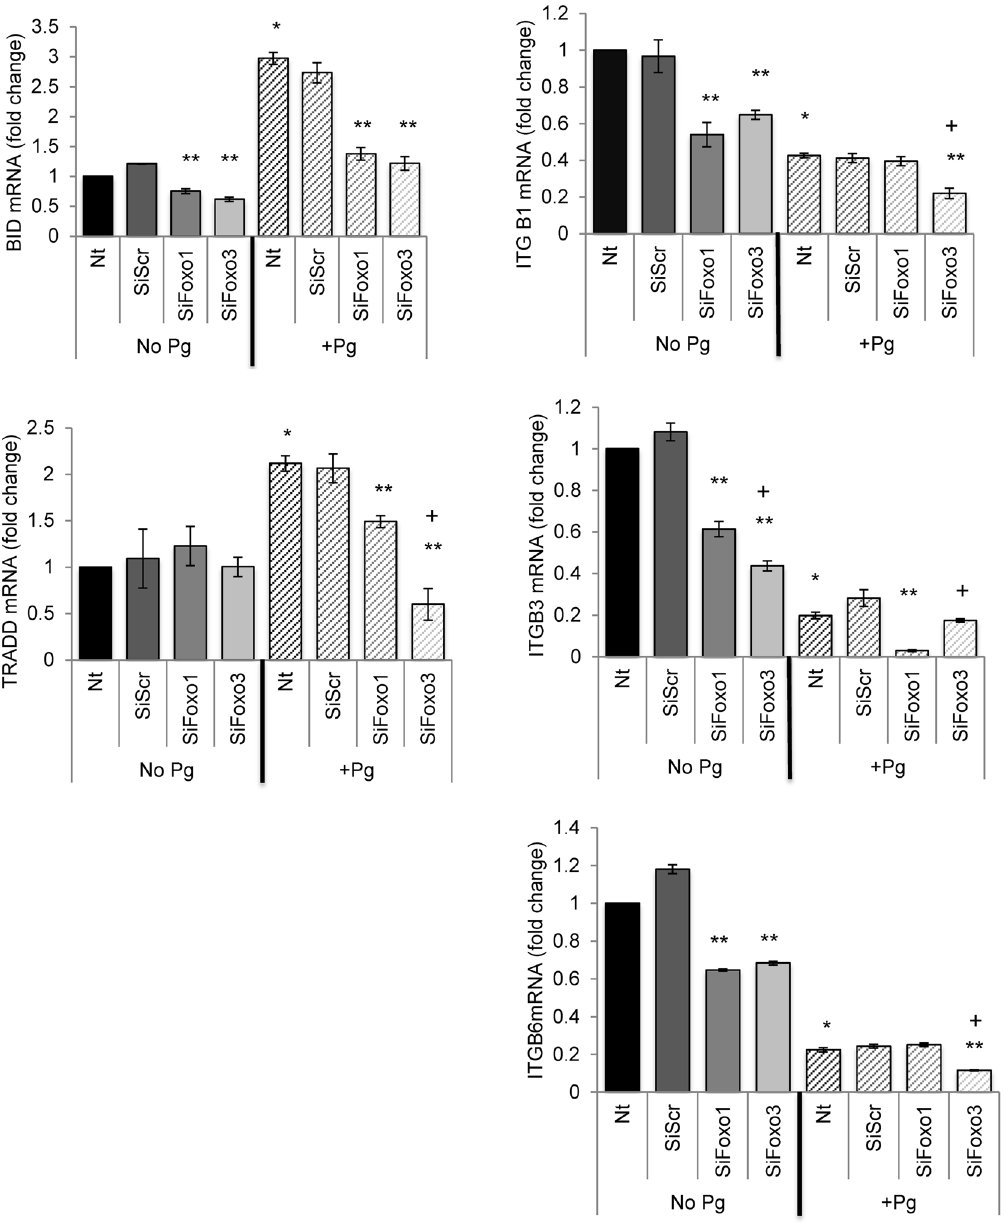
Figure 8. P.gingivalis modulates mRNA levels of apoptotic and barrier function genes through FOXO1 or FOXO3. Primary human gingival epithelial cell cultures were incubated with or without P. gingivalis at MOI=1:50 for 20 hrs. In some cases cells were pre-incubated with FOXO1 siRNA (SiFOXO1), FOXO3 siRNA (SiFOXO3) or scrambled siRNA (SiScr) FOXO1 prior to stimulation with bacteria. mRNA levels of apoptotic genes (BIDD and TRAD) and integrins that affect barrier function (beta-1, beta-3 and beta-6) were measured by real-time PCR. * Significantly different from control cells without bacterial stimulation (P , 0.05). ** Significantly different between scrambled siRNA and FOXO1 or FOXO3 siRNA (P , 0.05). + Significantly different between FOXO1 siRNA and FOXO3 siRNA (P ,